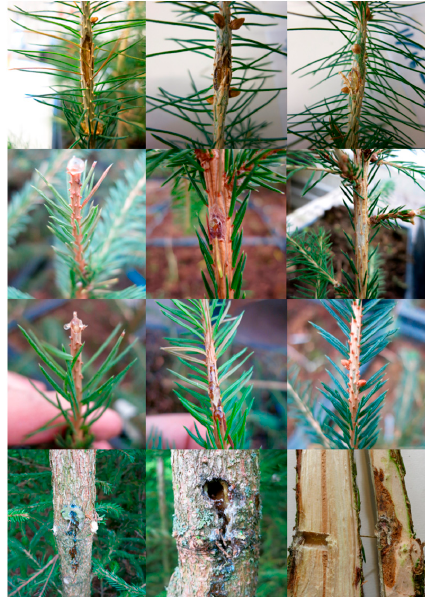
Figure 2. Symptoms observed in the inoculation trials with N. fuckeliana on Norway spruce ( Picea abies ): Top row = pilot study (the first inoculation trial) using microconidia from isolate no. 250603 (left), isolate no. 250605 (middle), and isolate no. 250603 (right), resulting in dark necrotic canker wounds with resin production. Photographed during assessment in 2016, 2 months after inoculation. Second row = greenhouse study part I (the second inoculation trial) where four different treatments (shoot-topped [left], shoot-wounded [middle], needles-removed [right], and non-wounded) were applied to the terminal leader of actively growing and dormant cuttings. Photographed during assessment in 2017, 10 months after inoculation. Third row = greenhouse study part II (the third inoculation trial) where the biggest branch shoot was inoculated using the same four treatments as in the second inoculation trial. Photographed during assessment in 2017, 8 months after inoculation. Fourth row = field study (the fourth inoculation trial) where 7-year-old Norway spruce plants were inoculated with mycelial plugs of N. fuckeliana in the stem. Photographed during assessment in 2017, 11 months after inoculation. Photos: Martin